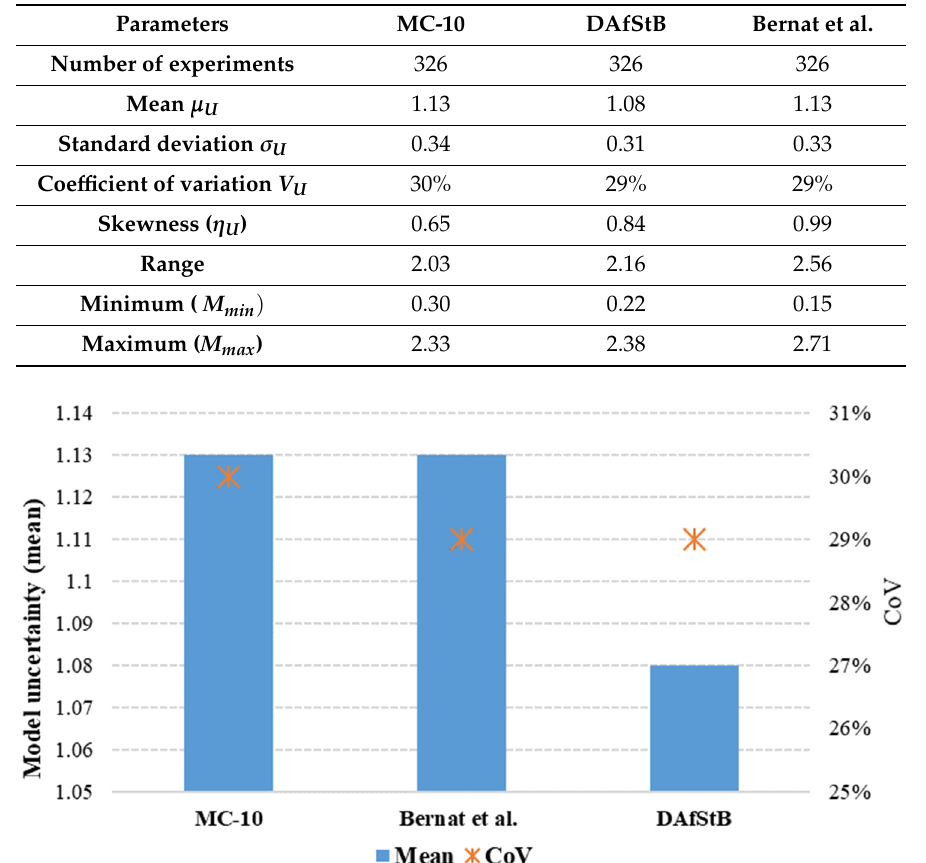
Figure 3. Mean and coefficient of variation for model uncertainty.